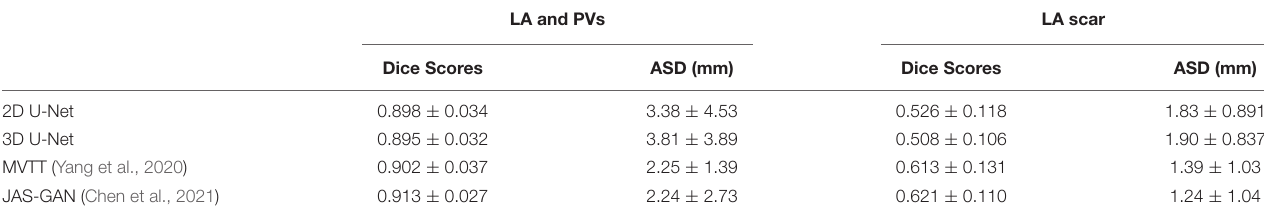
TABLE 7 | Result of a private benchmarking (Chen et al., 2021) of different algorithms on the LASC’18 dataset, reported in their mean ±